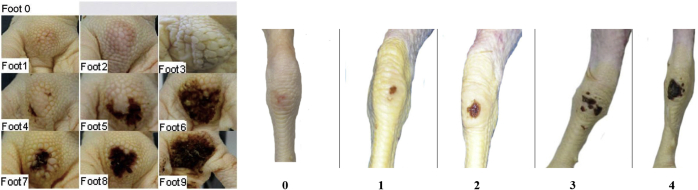
Scoring system for footpad lesions (left) and hock lesions (right) based on visual observations.